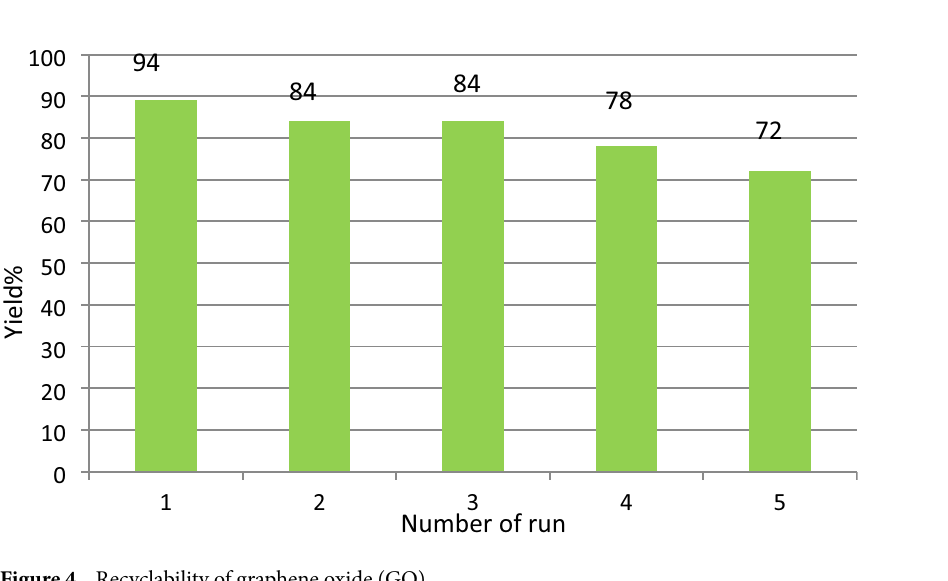
Figure 4. Recyclability of graphene oxide